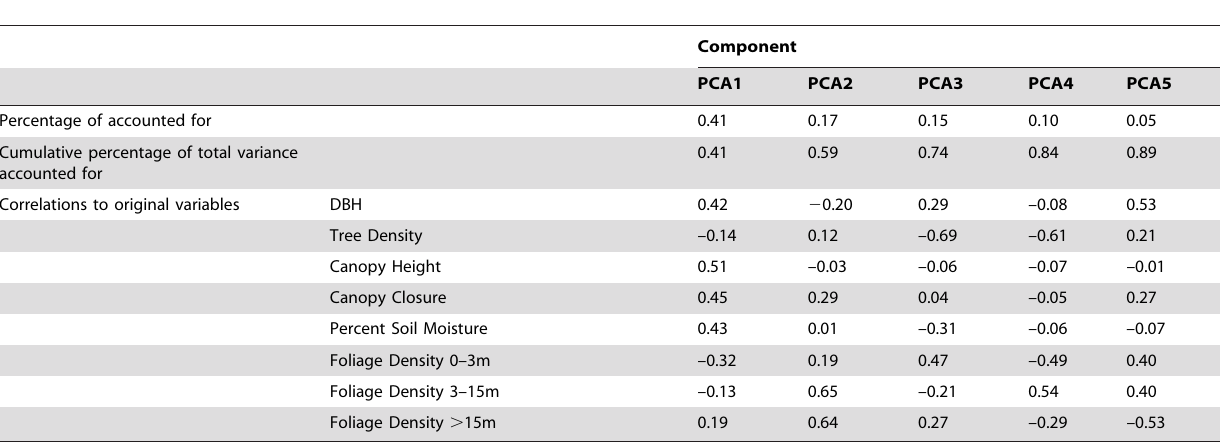
Table 3. Principal Component Analysis results summary of eight habitat and vegetation